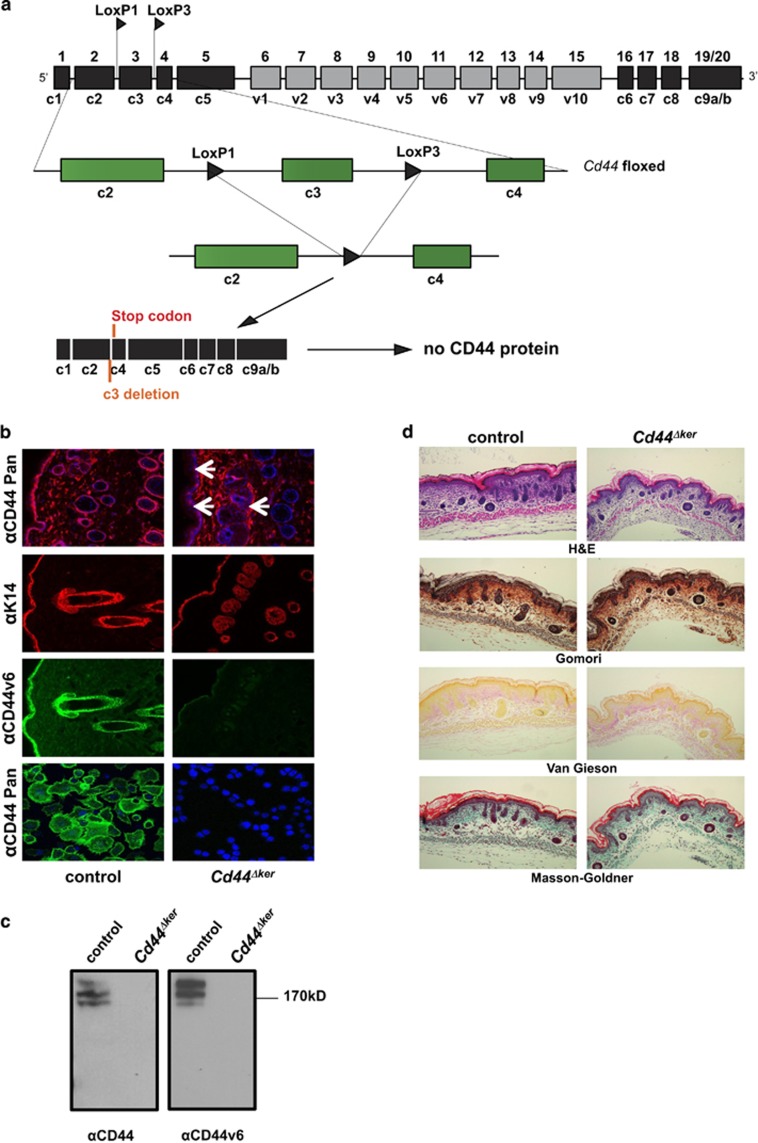
Knockout of CD44 in the skin. (a) Schematic representation of Cd44 conditional knockout allele. Upon crossing of the Cd44 floxed mice with K14Cre mice deletion of the Cd44 exon 3 leads to a frameshift and a stop codon disrupting the expression of all isoforms. (b) A pan CD44 antibody (IM7; red, green), a CD44v6 specific antibody (9A4; green) or a keratin 14 antibody (red) was used for indirect immune fluorescence staining of skin sections or keratinocytes (lower panel) harvested from Cd44Δker mice or control animals. Nuclei were counterstained with DAPI (blue). White arrows indicate areas where CD44 is removed (epidermis, hair follicles). (c) Western Blot analysis of lysates of keratinocytes, obtained from CD44Δker
Cd44 and control animals using a pan CD44 antibody (KM201) or a CD44v6 specific antibody (α9A4). (d) New born Cd44Δker or control skin stained for: H&E, Gomori Trichrome, Verhoeff‘s Van Gieson and Masson Goldner